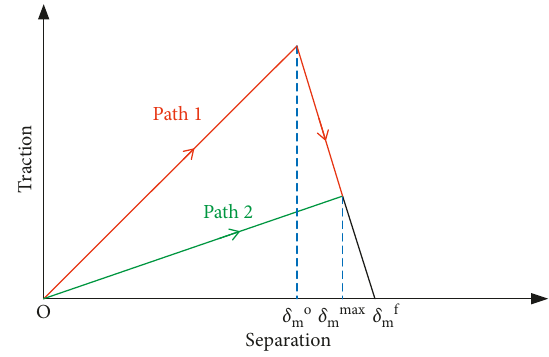
Figure 8: Schematic of the concept of δ max